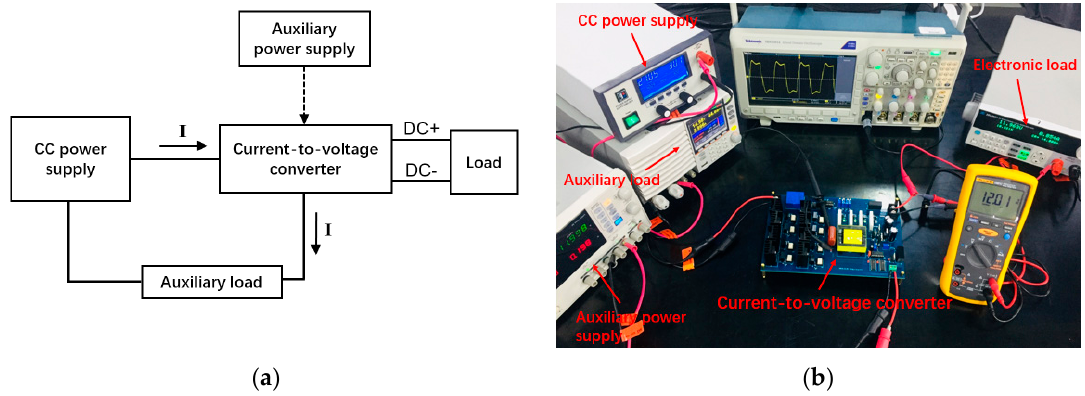
Figure 8. ( a ) The block diagram of the experimental setup; ( b ) the photograph of the experimental setup.